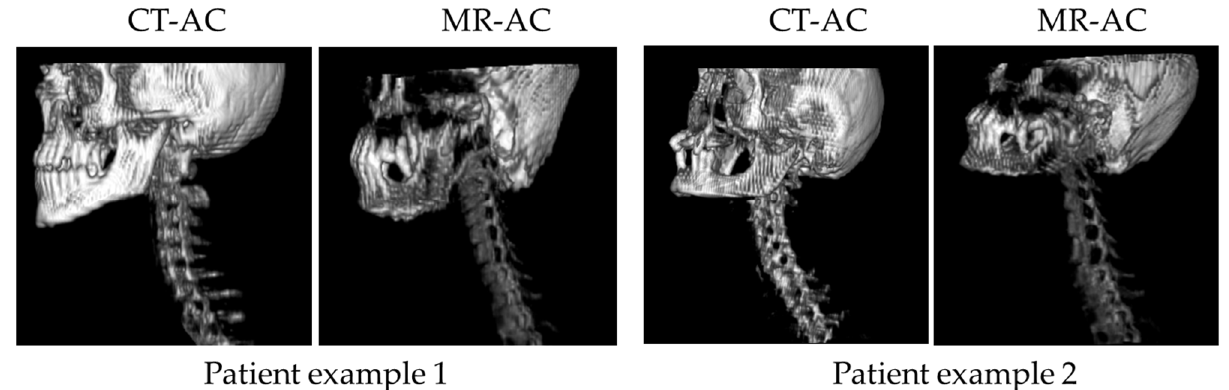
Figure 3. Comparison of 3D renderings of bone in CT-based and MR-based AC of two patient examples. While CT-based AC depicts the true bone anatomy (only skull and spine extracted from CT data for better comparability to MR-based AC) of each patient, bones in the MR-based AC result from an atlas-based approach and thus, represent the “best-match” between the bone model and the actual patient anatomy. Note that the spine bends differently in CT-based AC and MR-based AC due to the different patient positioning in PET/CT and PET/MR exams.